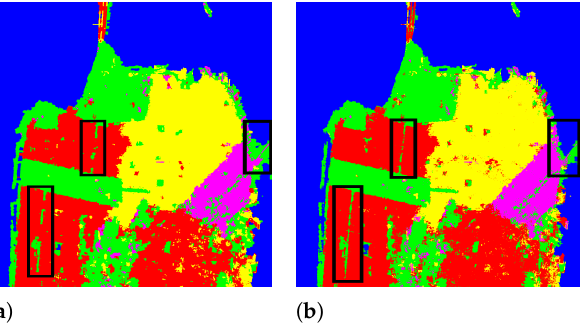
Figure 13. Classification results on the San Francisco dataset ( a ) without the polarimetirc second-order matrix kernel, and ( b ) with the polarimetirc second-order matrix kernel.